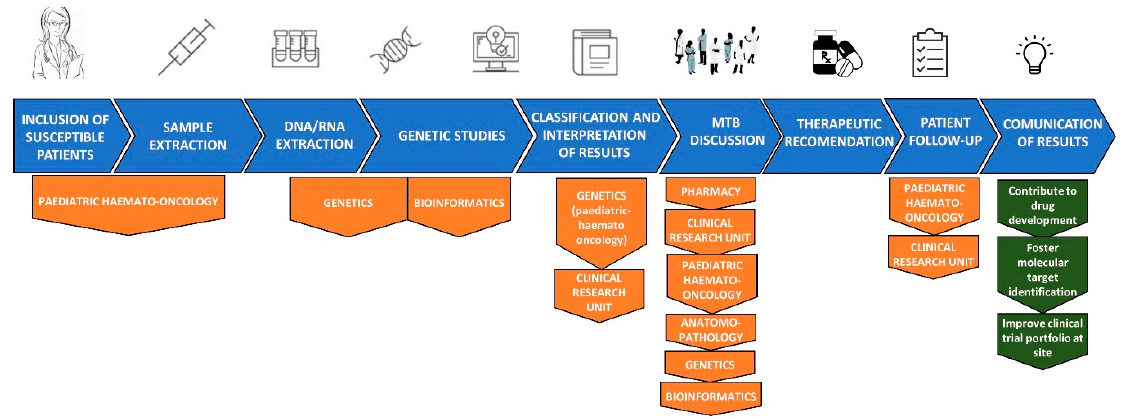
Figure 1. Work flow from sample collection to MTB recommendation.